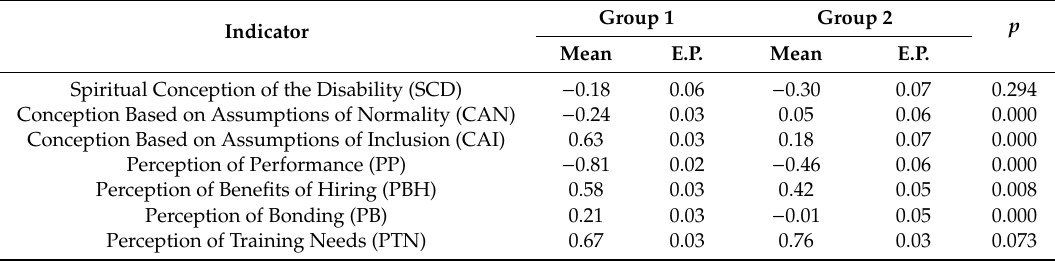
Table 5. Characterization of the groups